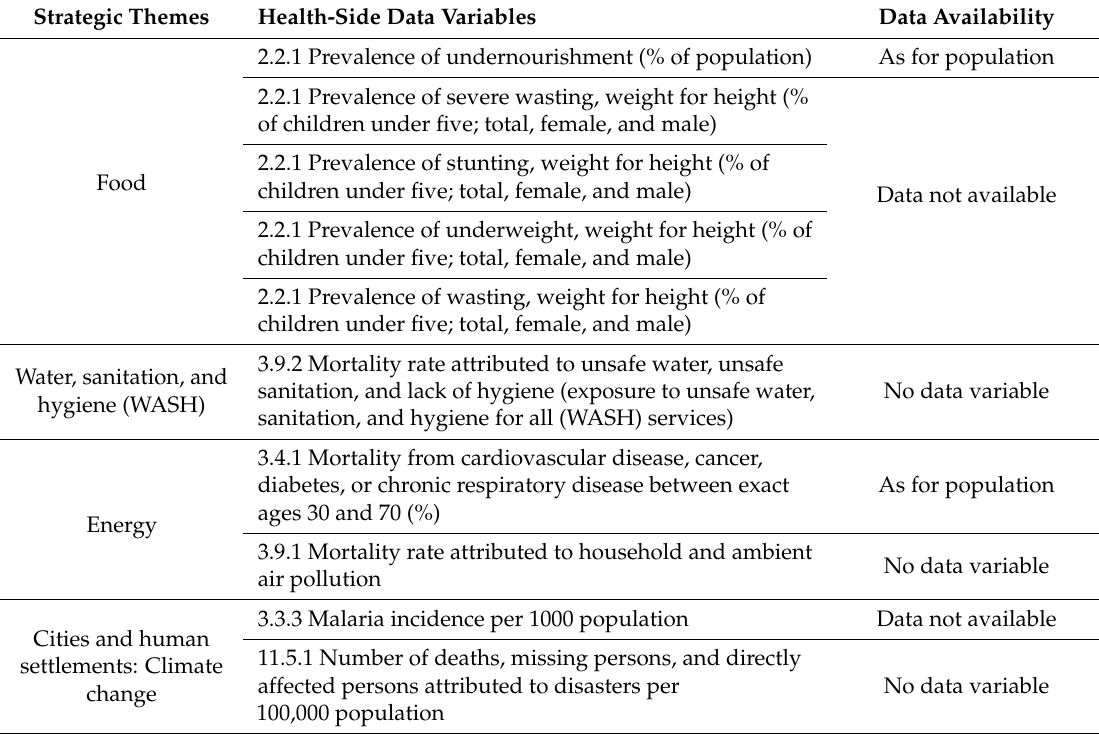
Table 3. Data on the selected health outcomes in